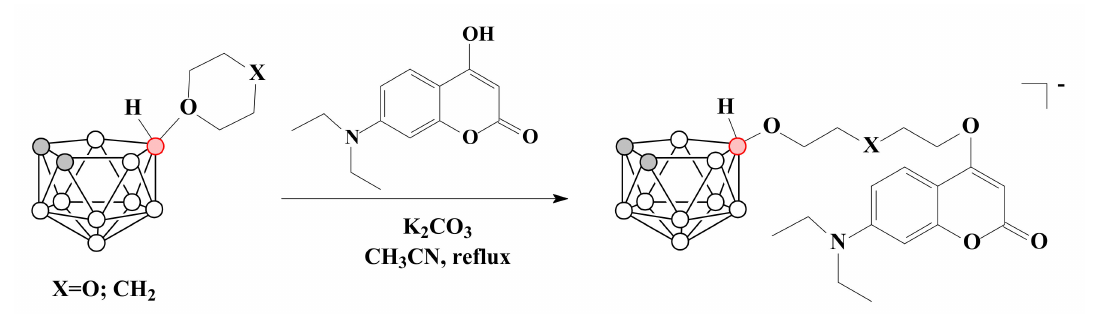
Scheme 6. The synthesis of nido -carborane conjugates with